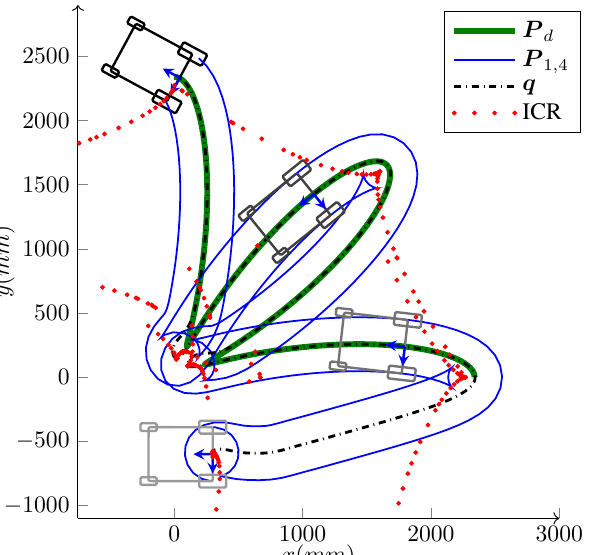
Figure 9. Experiment : Bounded velocity path-following with large initial errors for LabRat WMR ( δ = ( 2,0 ) ). It seeks and follows the path P d while correcting its heading from the initial heading error of 180 ◦ toward the path tangent angle ψ t ( s ) −